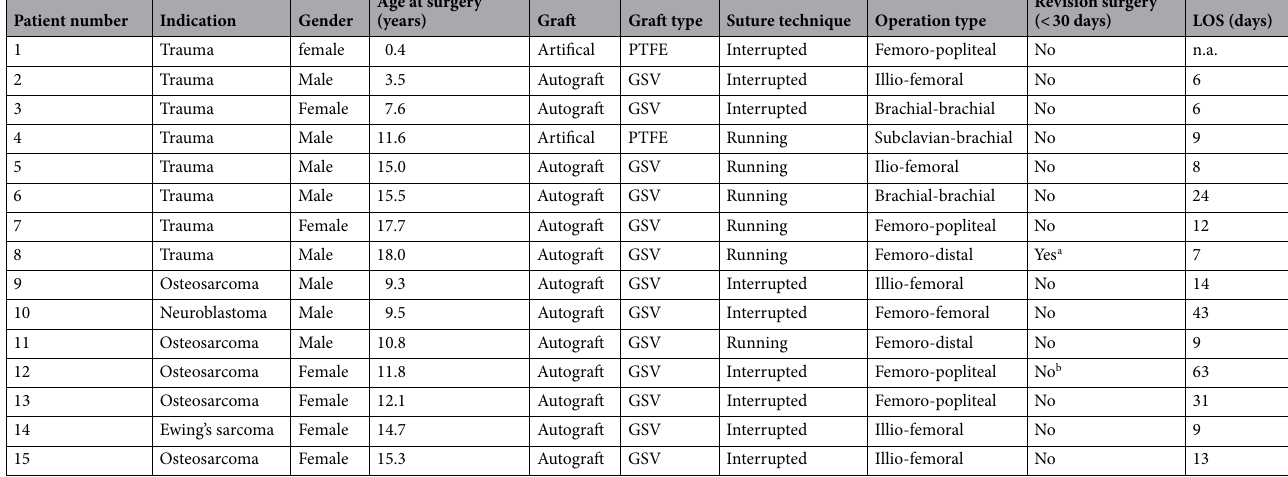
Table 2. Patient characteristics–vascular surgery. gsv great saphenous vein. a Postoperative bleeding treated by interrupted suturing. b Postoperative ischemia treated by